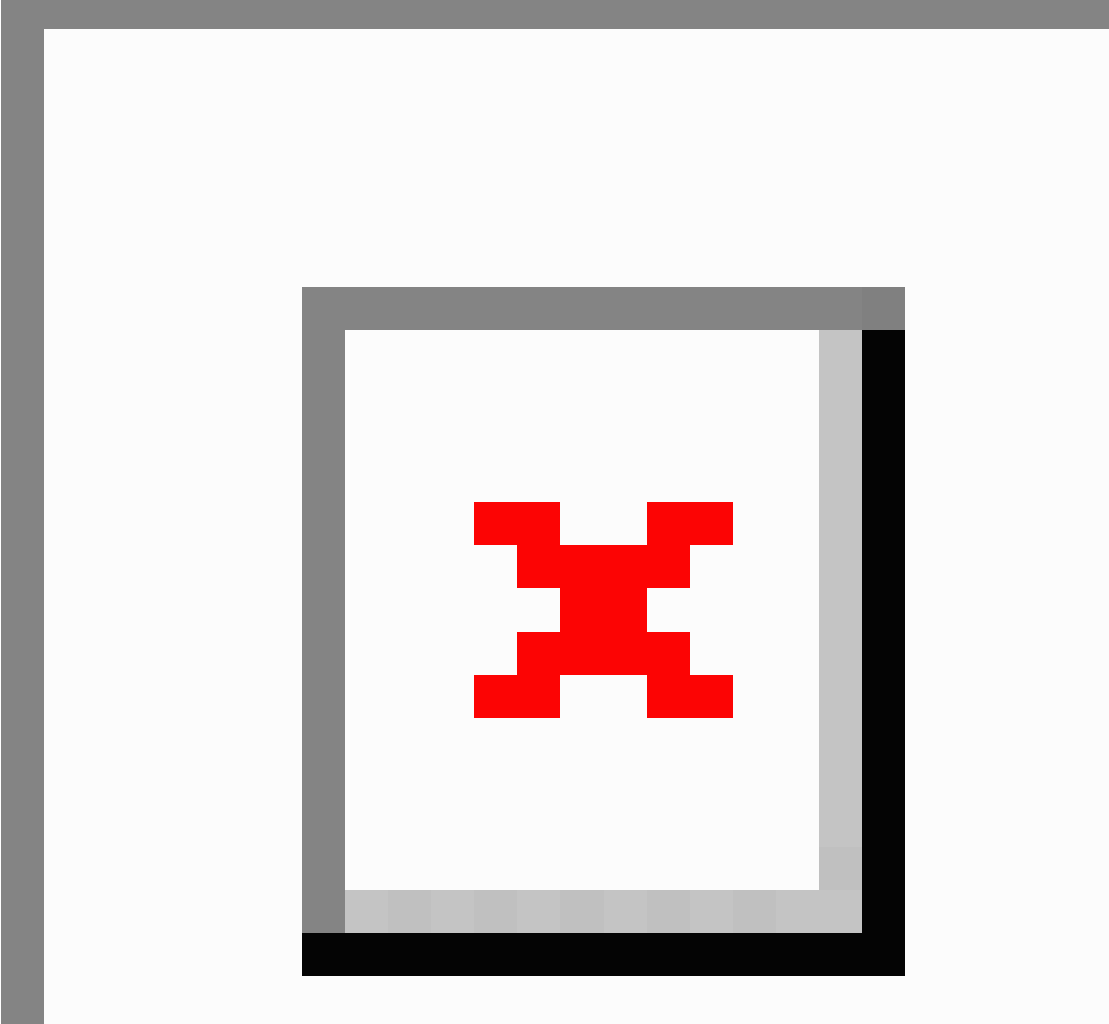
Figure 3. Anxiety apps in different categories on Google